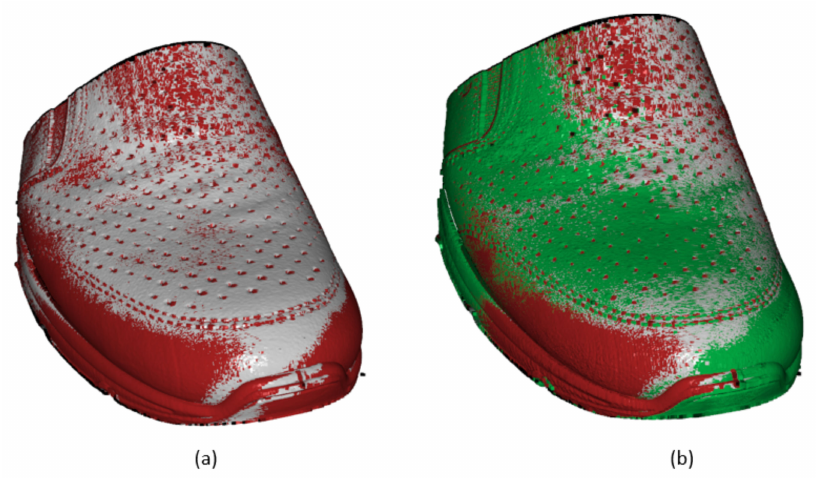
Figure 12. Inspected scan 10 ( a ) and inspected scan with etalon scan ( b